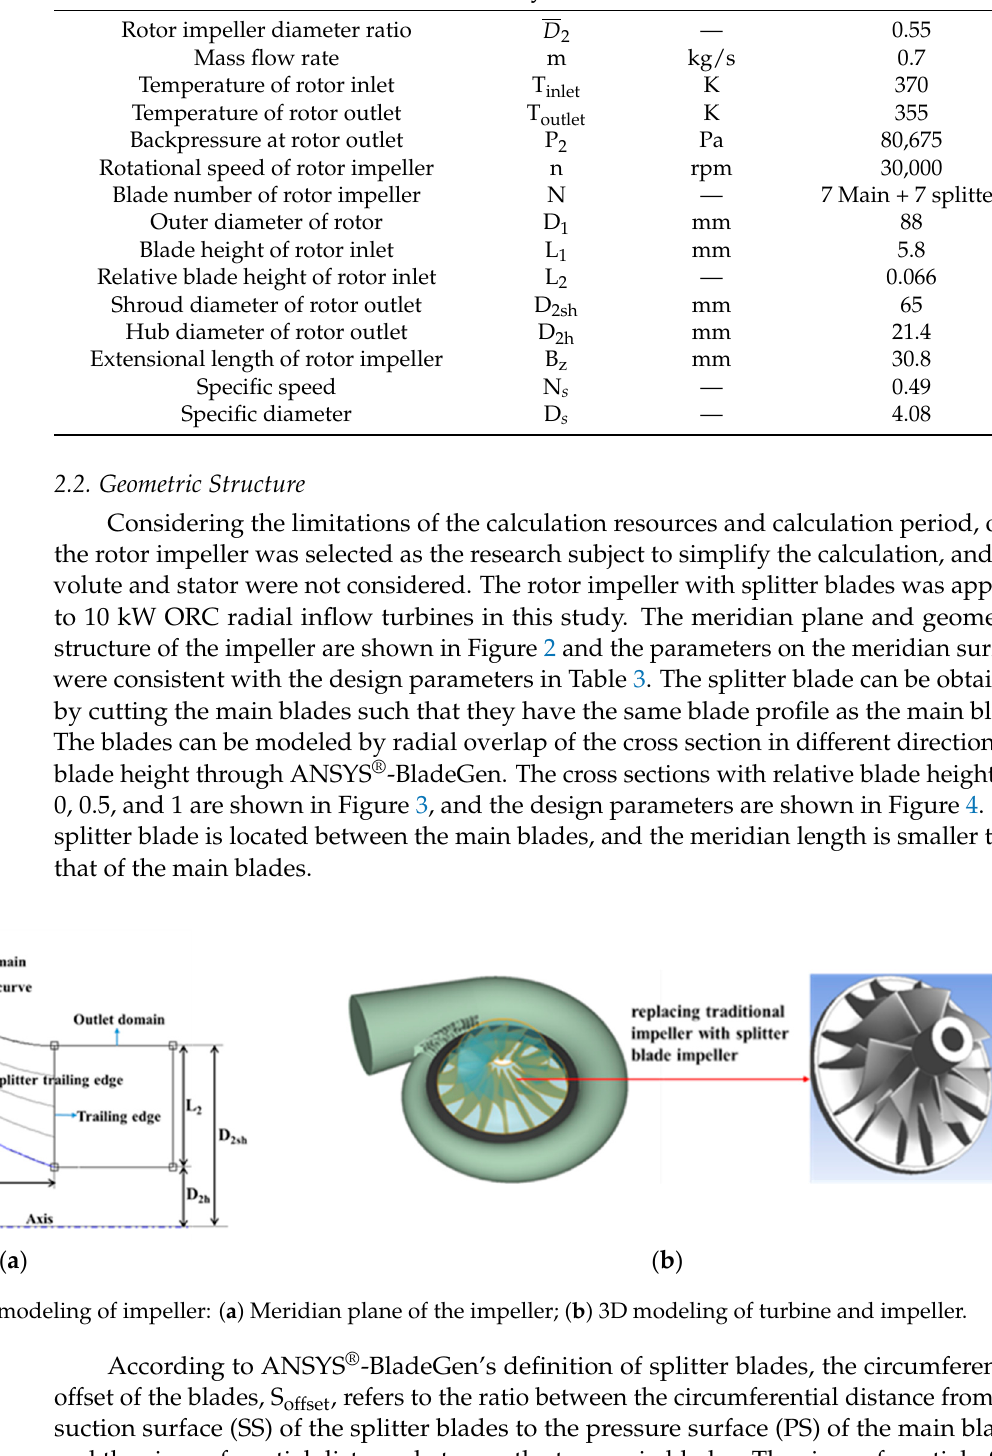
5 of 21 Table 3. Table of design parameters for impeller. Name